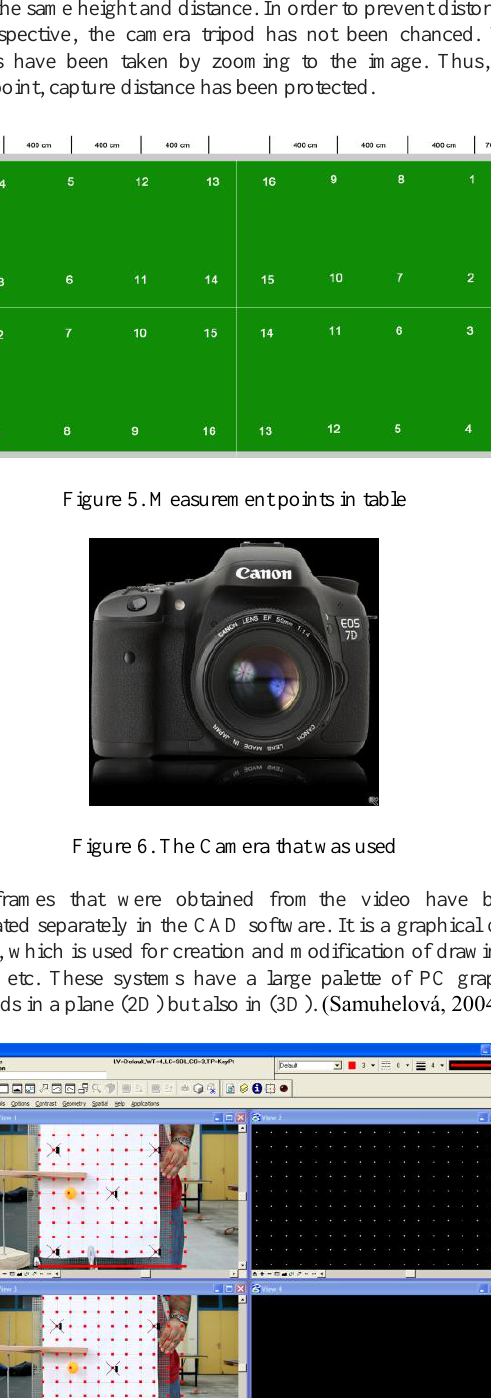
Figure 4. ITTF approved table tennis ball